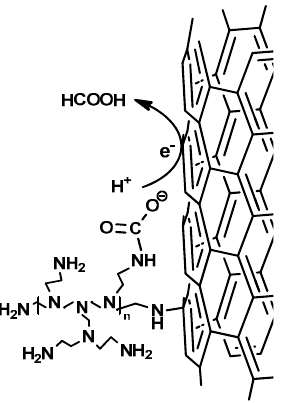
Figure 8. Activation of CO 2 in photoreduction by PEI through carbamate formation.